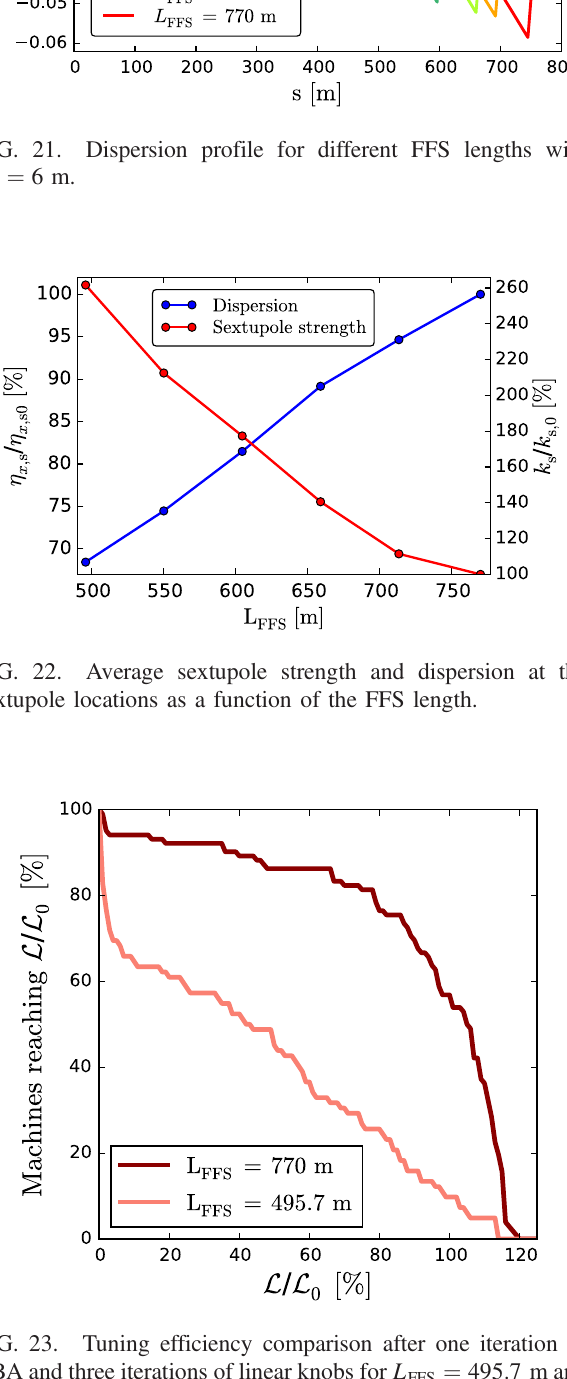
¼ 495 . 7 m and FFS